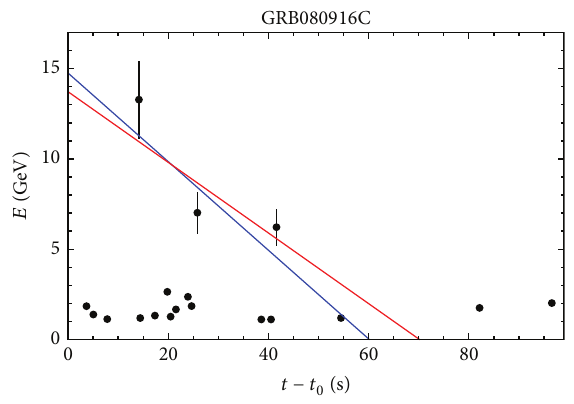
Figure 17: The blue line and the data points in this figure exactly match the ones for Figure 10, concerning GRB08091C. The only difference is that now we add the red line whose slope is obtained from the slope fit in Figure 4 (for GRB130427A) by rigidly rescaling it by the factor of 1.34 2 /5.35 2 , that is, (1+𝑧 1 ) 2 /(1+𝑧 2 ) 2 for 𝑧 1 = 0.34 (GRB130427A) and 𝑧 2 = 4.35